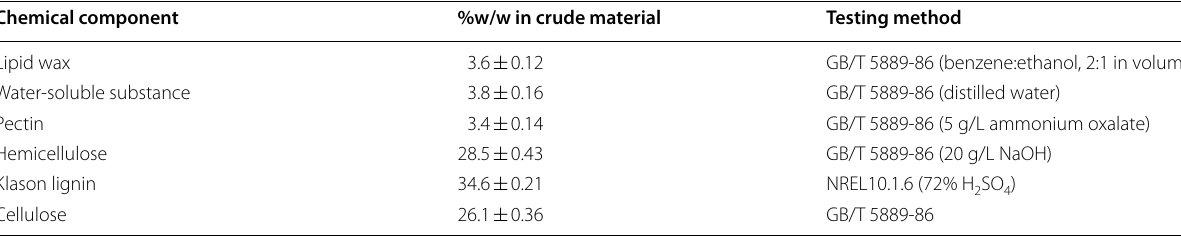
Table 3 Composition of the palm fiber (dry mass wt. %) Chemical component